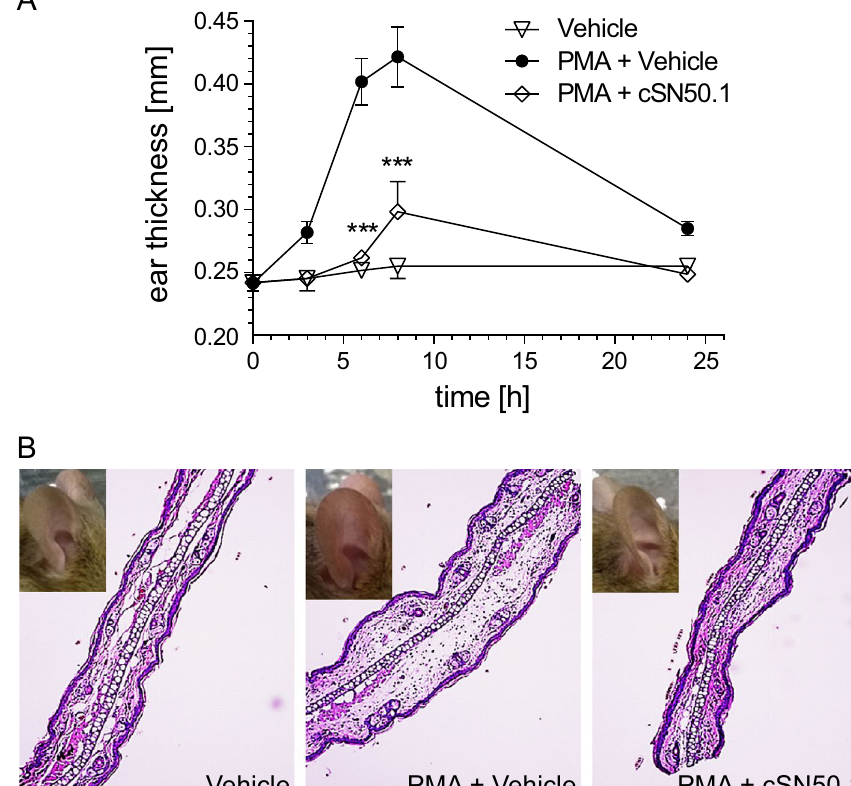
Figure 5. NTCI treatment reduces PMA-Induced ear inflammation. A single dose of Phorbol Myristate Acetate (PMA, 2 nmoles in 10 µl EtOH on each side) was administered topically to the right ear of 8-week- old female C57Bl/6 mice. Topical treatment with NTCI, cSN50.1 peptide (16.7 nmoles in 10 µl EtOH on each side), or vehicle (10 µl EtOH on each side) was administered 30 min before and 3, 6, and 8 h. after PMA challenge. A control group of mice was treated topically with vehicle only (10 µl EtOH) following the same treatment schedule. ( A ) Ear thickness was measured at 30 min before (0 h) and 3, 6, 8 and 24 h. after PMA challenge. Measurements are represented as mean ± S.E.M. (n = 5). Statistical significance of the difference between ear thickness in NTCI-treated mice (PMA + cSN50.1) and vehicle treated (PMA + Vehicle) or vehicle control (Vehicle) groups was determined by two-way ANOVA using corrected Holm-Sidak test for multiple comparison, *** p < 0.0005. ( B ) Ear images show increased swelling and redness induced by PMA (PMA + Vehicle). H & E staining of paraffin-embedded ear punch biopsies, collected 8 h. after PMA challenge, show increased swelling. Both signs of inflammation (redness and swelling) are reduced by NTCI treatment (PMA + cSN50.1). Displayed are representative images (× 20 magnification) of pinna